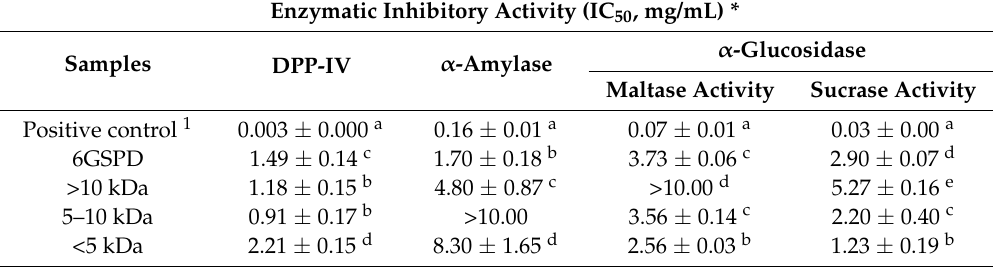
* Values are the mean ± standard deviation of three independent experiments. Different lowercase letters indicate significant differences among samples ( p ≤ 0.05, Holm-Sidack’s test). 1 Positive control was Diprotin in DPP-IV inhibitory assay and Acarbose in α-amylase and α-glucosidase inhibitory assays.